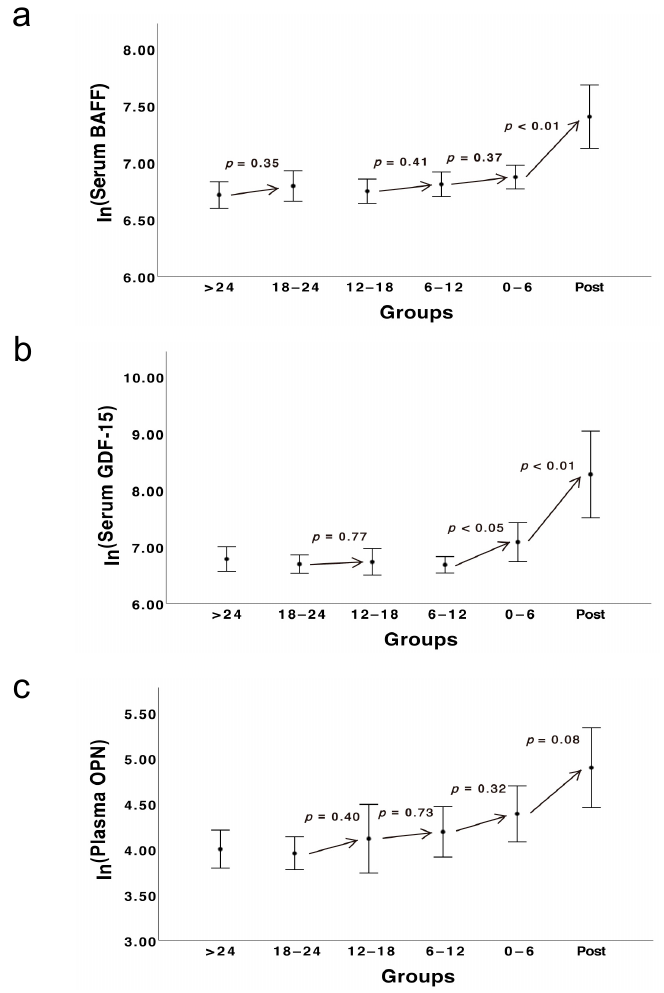
Figure 6. The trends of three biomarkers in a 24-month period before clinical diagnosis of metastatic UM in 24 patients. The blood specimens were divided into six groups according to the acquiring time before the diagnosis of metastases, i.e., >24 months, 18–24 months, 12–18 months, 6–12 months, 0–6 months and those acquired after the metastases (= Post). The arrows show the increasing trends between two adjacent groups. ( a – c ) The black dots show the mean of the natural logarithm transformed blood-based levels of BAFF, GDF-15 and OPN, respectively. The error bars represent the 95% confidence interval of the mean.